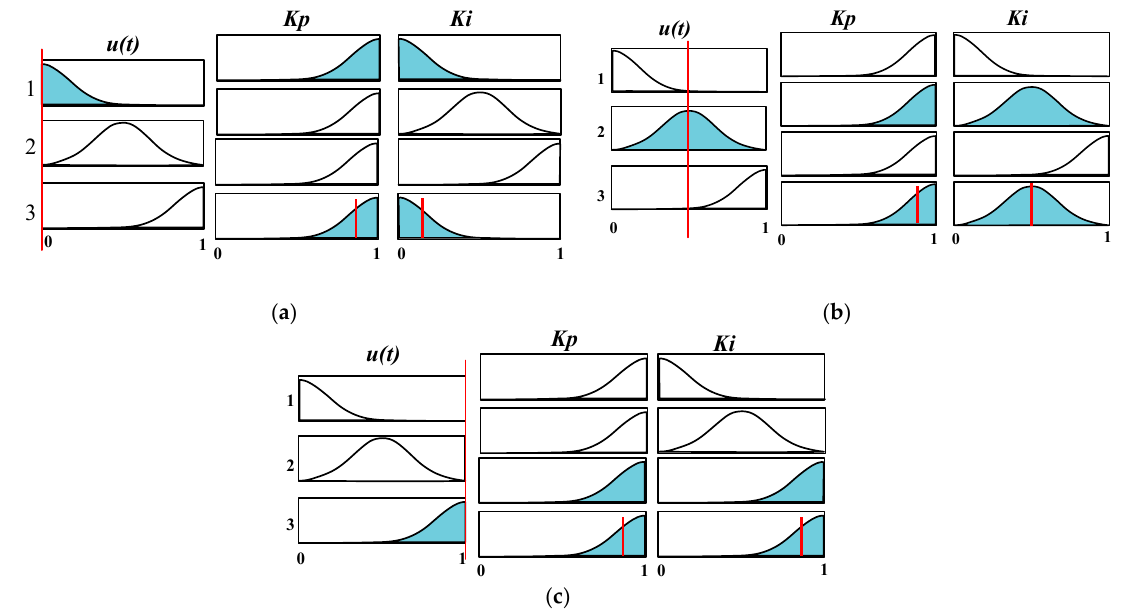
Figure 6. Adaptation of gain values where the: ( a ) error is zero, ( b ) error is small, and ( c ) error is large.